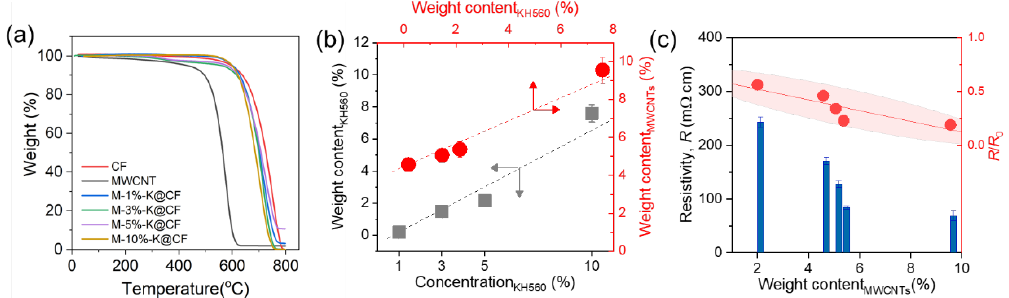
Figure 3. SEM images of ( a ) bare CF, ( b ) 10%-K@CF, ( c ) M-5%-K@CF, and ( d ) M-10%-K@CF.